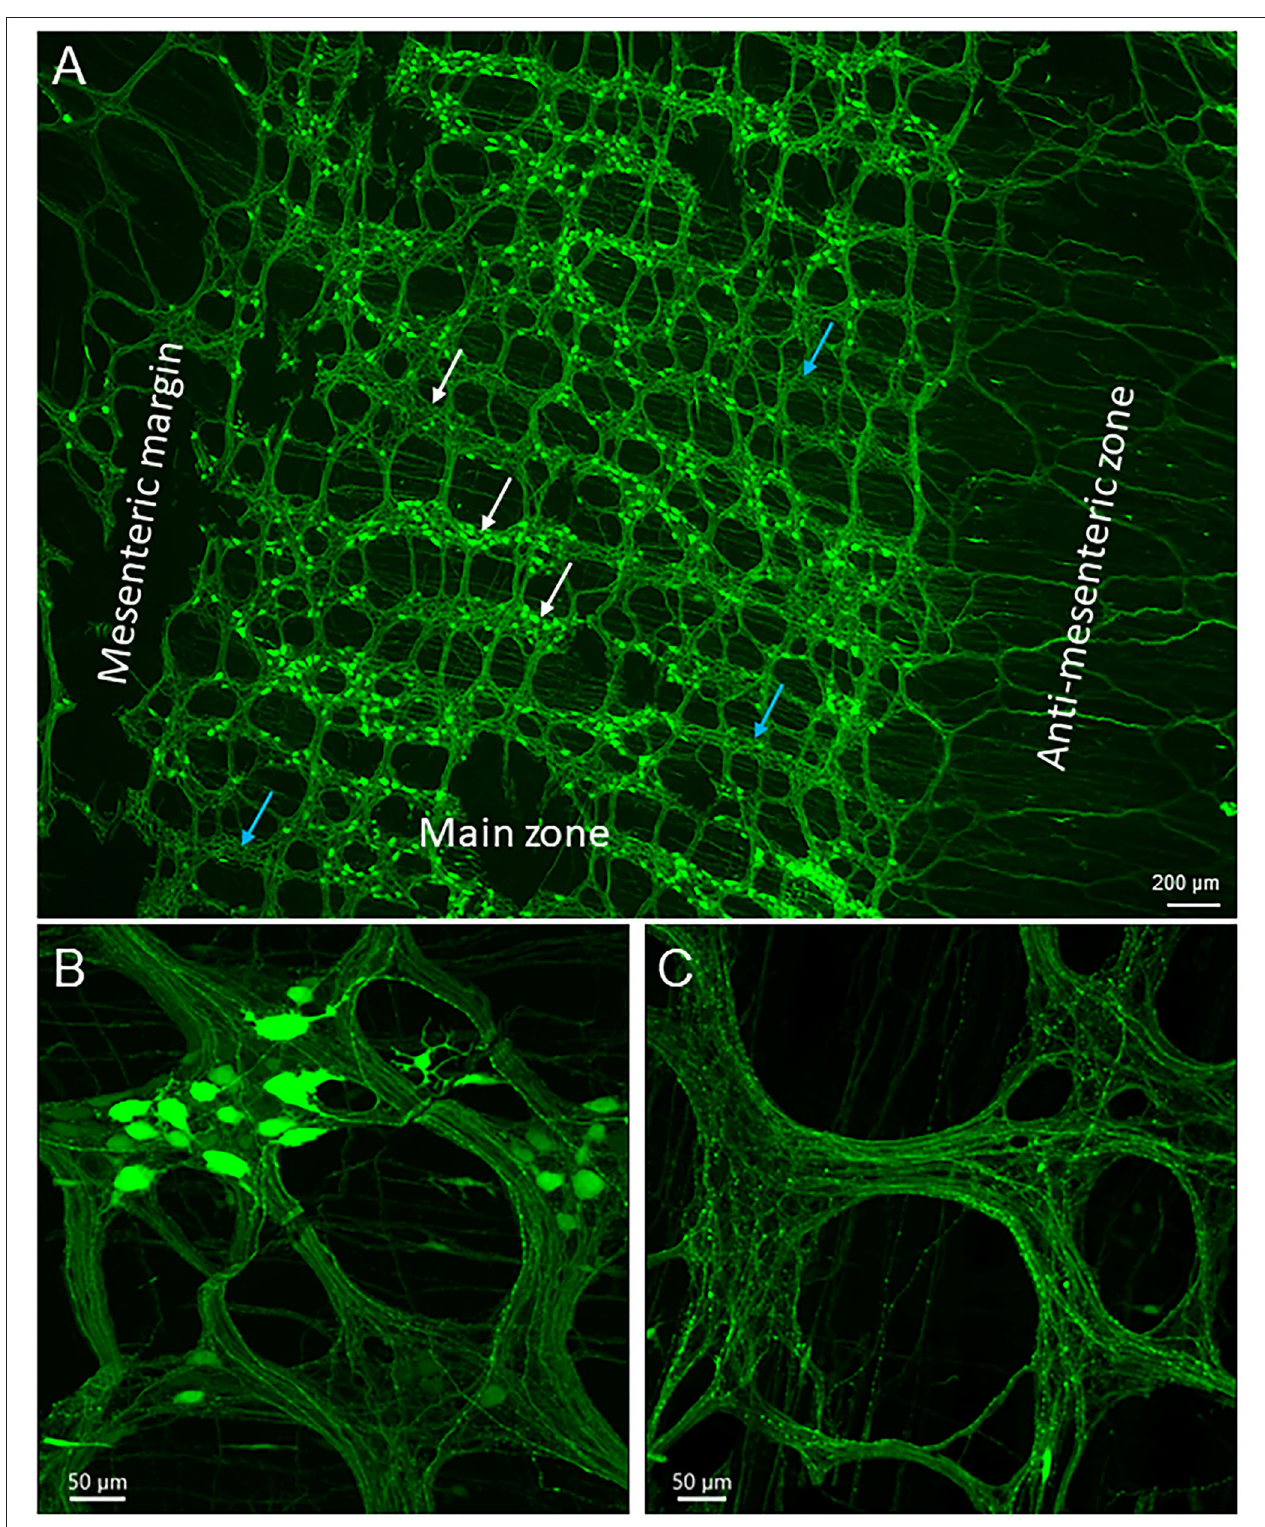
FIGURE 2 | Uneven distribution of AAV9 transduced neurons in the myenteric plexus in the mouse proximal colon by retro-orbital injection of the vector. The two doses of 3.3 x 10 11 and 1 x 10 12 GC/mouse result in the same pattern. Numbers of AAV9-labeled neurons vary largely from area to area among the ganglia: numerous to none. Labeled nerve fibers are shown in all areas. (A) Low magnification stitch image of one side of the colonic wall in the segment about 2–3cm from